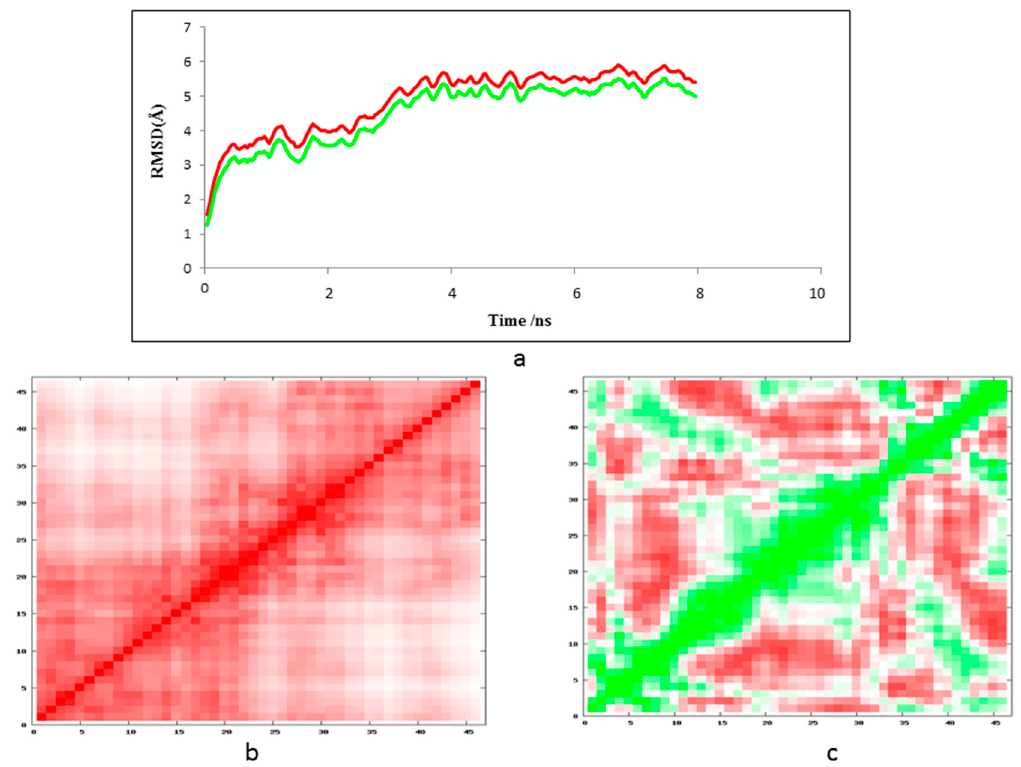
Figure 5. ( a ) MDWeb results of tau protein. Protein backbone RMSD graph for the modeled tau (green) and template tau (red) molecular dynamics (MD); ( b , c ) protein tau α C atom root mean square fluctuation (RMSF) values (in Å Angstroms) per residue square matrix graph for the tau before dynamics (red) and after MD dynamics (green).